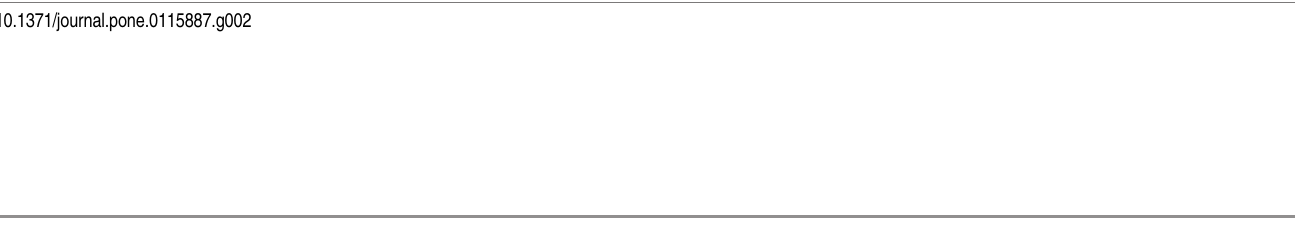
PLOS ONE | DOI:10.1371/journal.pone.0115887 December 22,